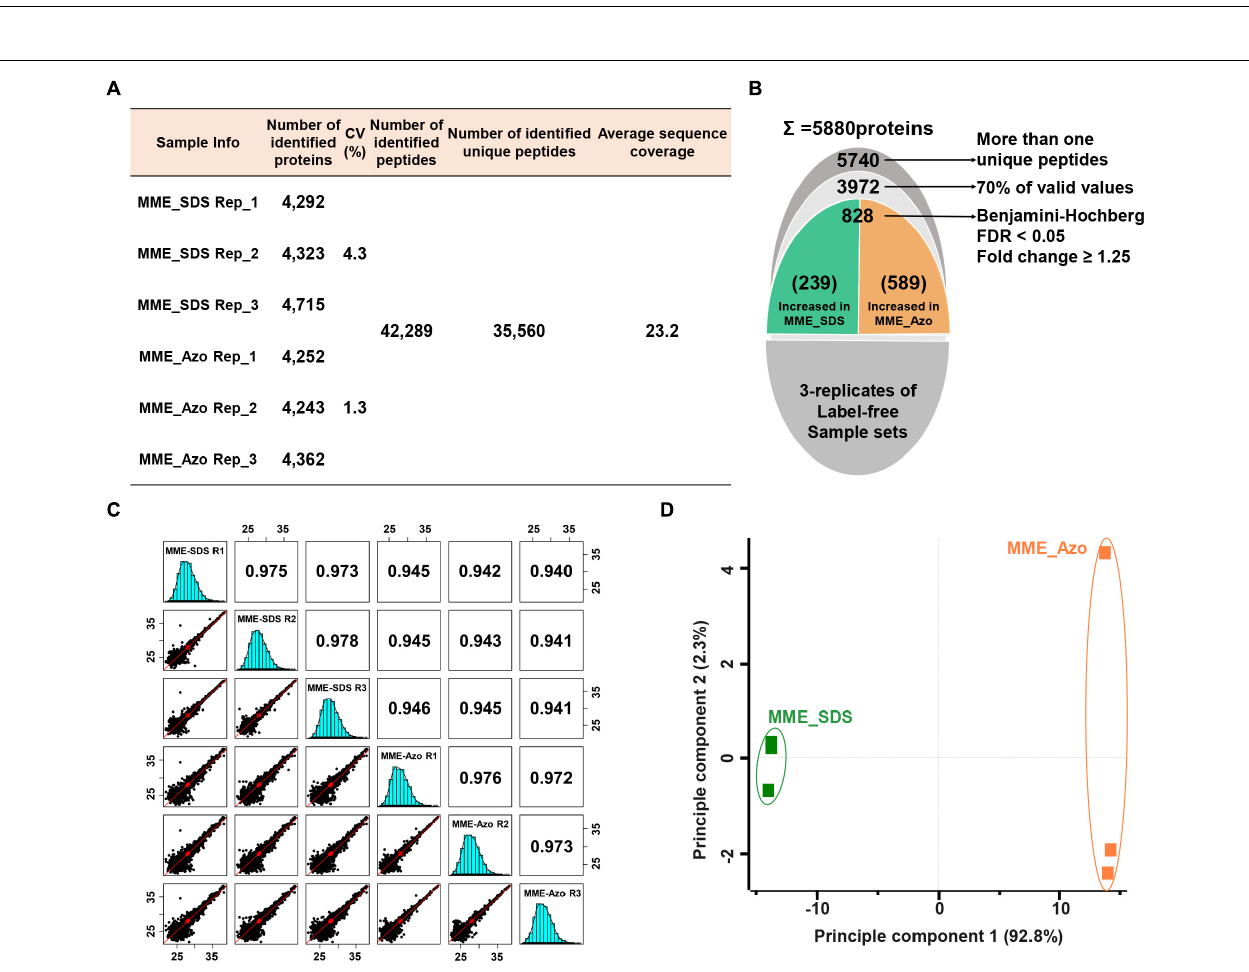
FIGURE 3 | Extraction of microsomal membrane proteins using the MME method and sequentially solubilized in the sodium dodecyl sulfate (SDS) and 4-hexylphenylazosulfonate (Azo) surfactants for label-free quantitative analysis. Further validation of the solubility of microsomal membrane proteins in the SDS and Azo surfactants and Western blot analyses using BiP, PIP2-1, and TIP1-1 antibodies were carried out.